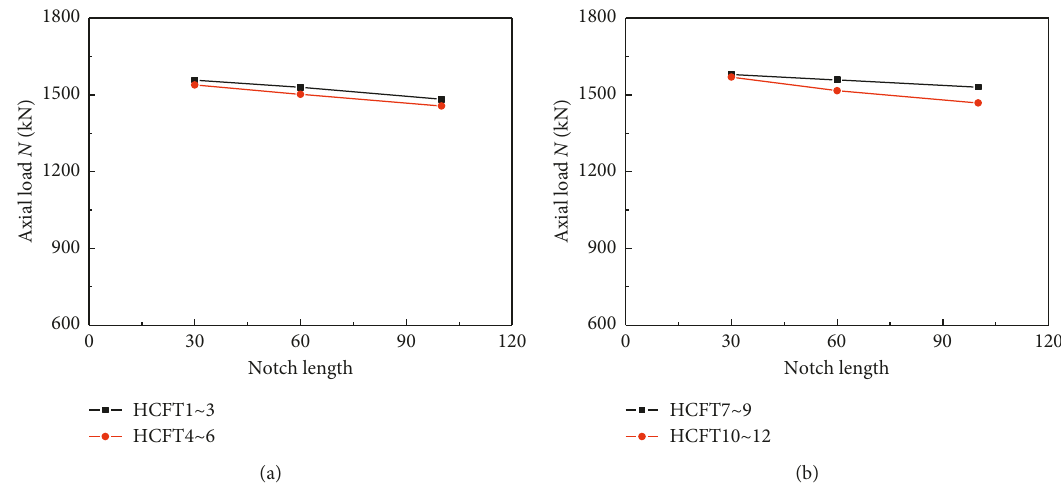
Figure 7: Influence of notch length on the ultimate strength of specimens. (a) Horizontal notch (HCFT1 ∼ HCFT6). (b) Vertical notch (HCFT7 ∼ HCFT12).